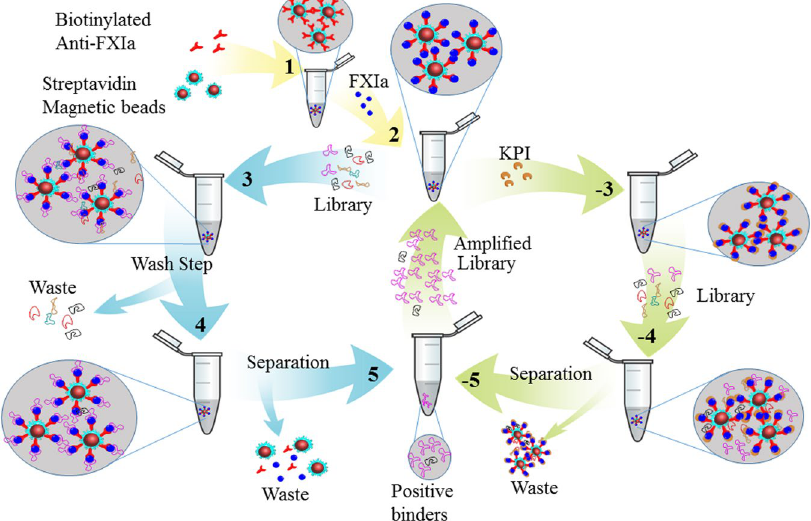
Figure 1. Schematic representation of aptamer library screening strategy. For rounds in which only positive selection was employed, biotinylated anti-FXIa antibodies and streptavidin-coated magnetic beads (1) were combined with FXIa (2) and the original aptamer library (3). Aptamer-FXIa-antibody-bead complexes were then concentrated magnetically and washed (4) prior to separation and recovery of selected aptamers via phenol/chloroform/isoamyl alcohol extraction and ethanol precipitation (5). Following asymmetric PCR to amplify the aptamer pool, steps 1–5 were either repeated directly or components from 1 and 2 were combined with the FXIa-active site inhibitor KPI ( − 3) for negative selection, magnetic concentration and washing ( − 4), separation ( − 5) and amplification, to complete rounds in which both positive and negative selection were